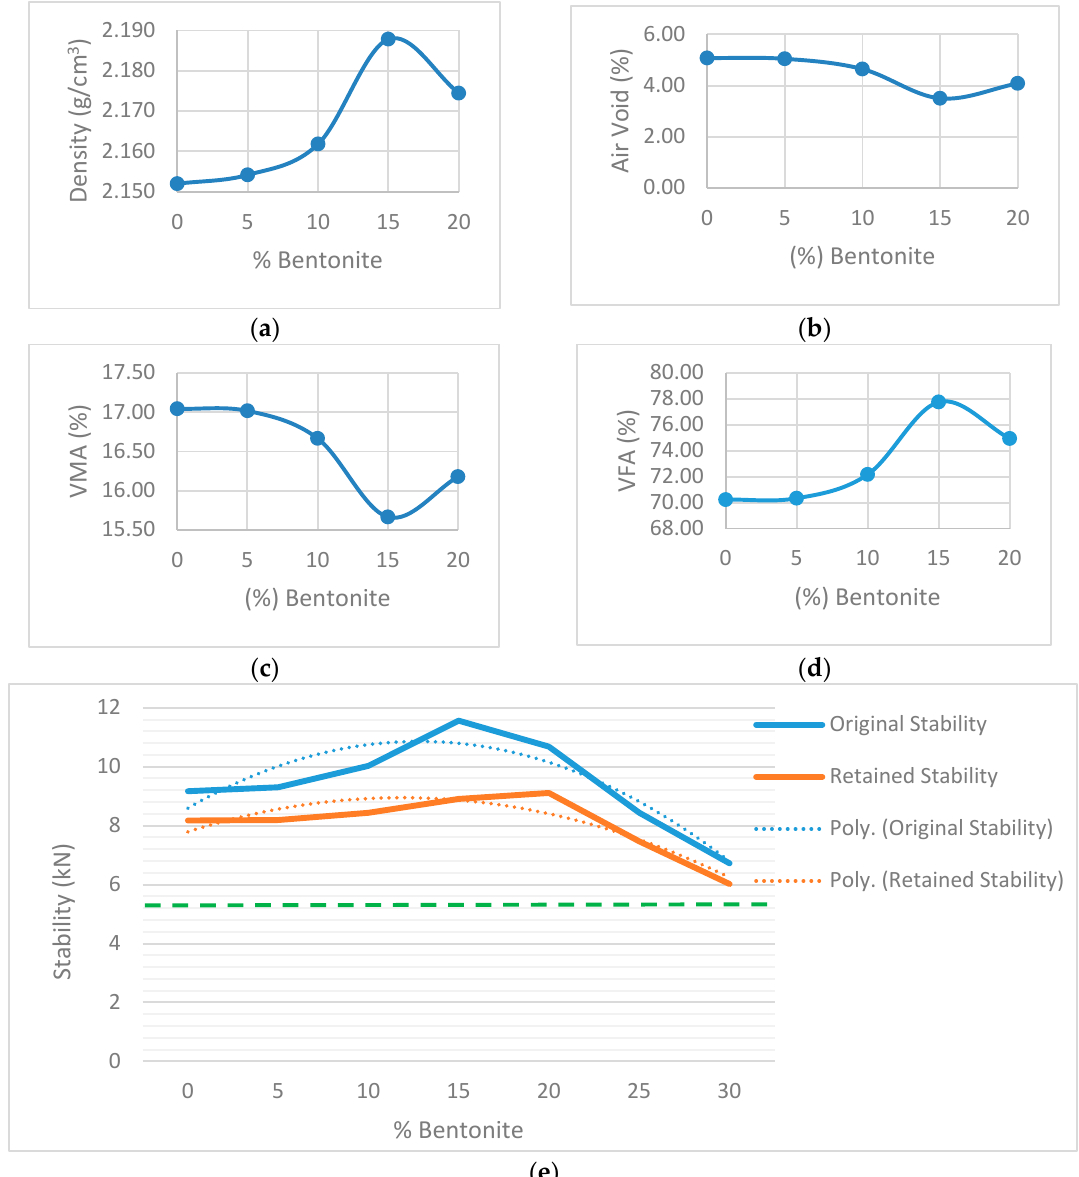
Figure 3. Bentonite variation with ( a ) density, ( b ) air void, ( c ) VMA, ( d ) VFA, and ( e ) original and retained stability (the green dotted line represents the minimum requirement for stability).